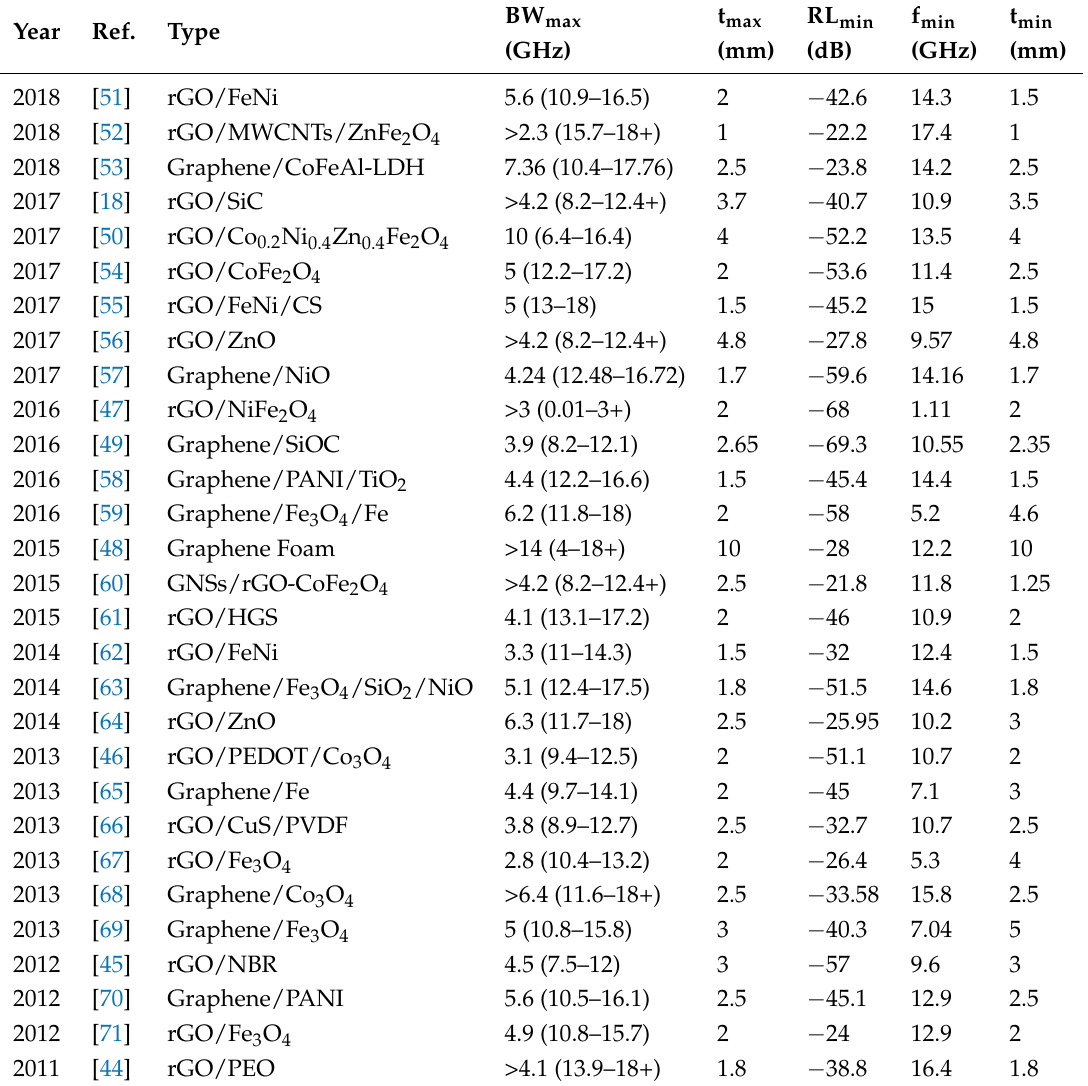
Table 1. Microwave absorption properties of graphene and its derivatives based composites. (BW: bandwidth; RL: return